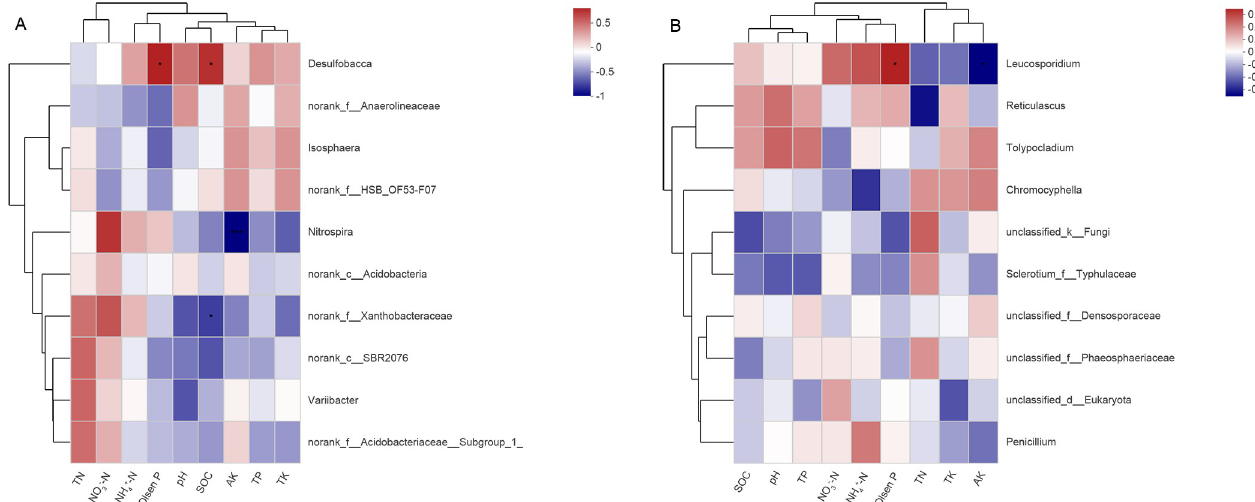
Fig 8. Correlation heatmap of soil properties and relative abundances of bacterial (A) and fungal (B) communities at the genus level. � 0.01 < P � 0.05; �� 0.001 < P � 0.01; ��� P � 0.001. Notes: T0 = Traditional irrigation; T1 = Traditional irrigation and fertilization practice; T2 = Water-saving irrigation and optimizing fertilization. SOC: Soil organic carbon; N: Nitrogen; TN: Total N; NO 3 − − N: Nitrate N; NH 4+ − N: Ammonium N; P: Phosphorus; TP: Total P; K: Potassium; TK: Total K; AK: Available